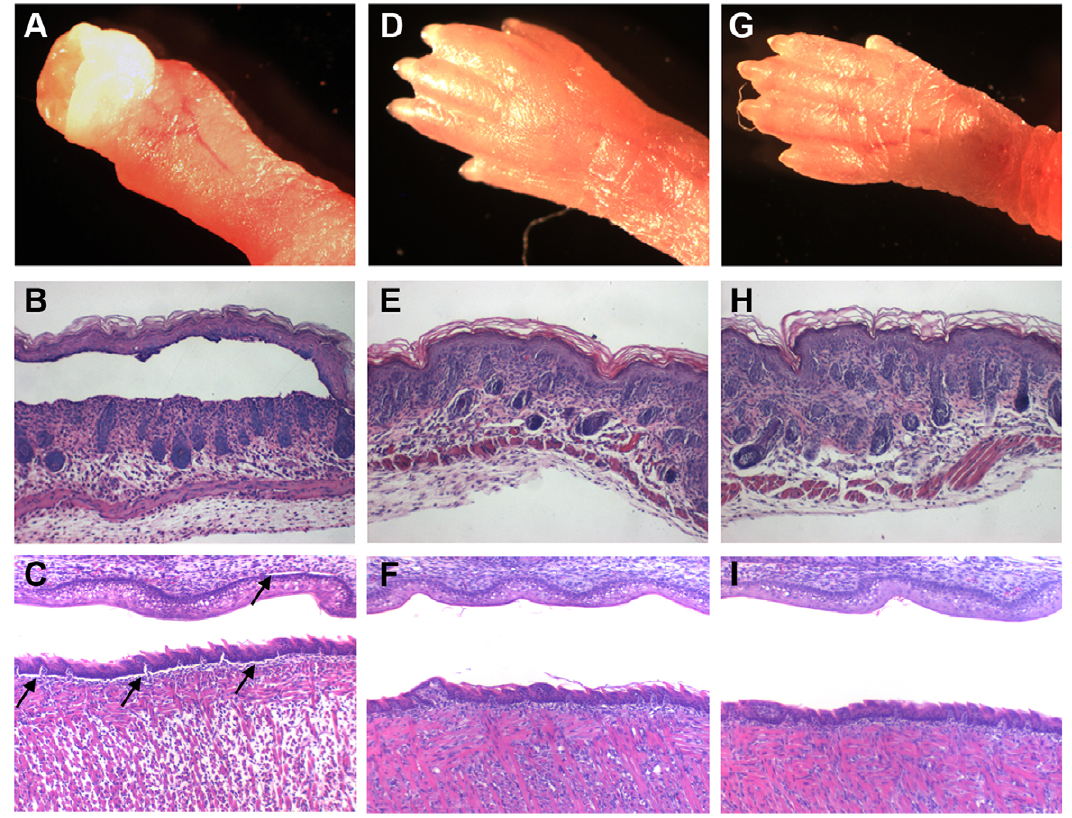
Figure 6. Expression of human laminin c 2 under the K14 promoter prevented blistering of rescued Lamc2 KO mice. The paws (A, D, G), skin (B, E, H), and mouth (C, F, I) of Lamc2 KO (A–C), rescued Lamc2 KO (D–F), and Lamc2 WT (G–I) newborn mice were examined. Skin blistering was most evident on the paws of Lamc2 KO (A), but epidermal detachment (B) and separation of the oral mucosa of the roof palate and tongue (arrows in C) were detected microscopically after H&E staining. Blistering was not observed in the rescued Lamc2 KO (D–F) or Lamc2 WT (G–I) mice.